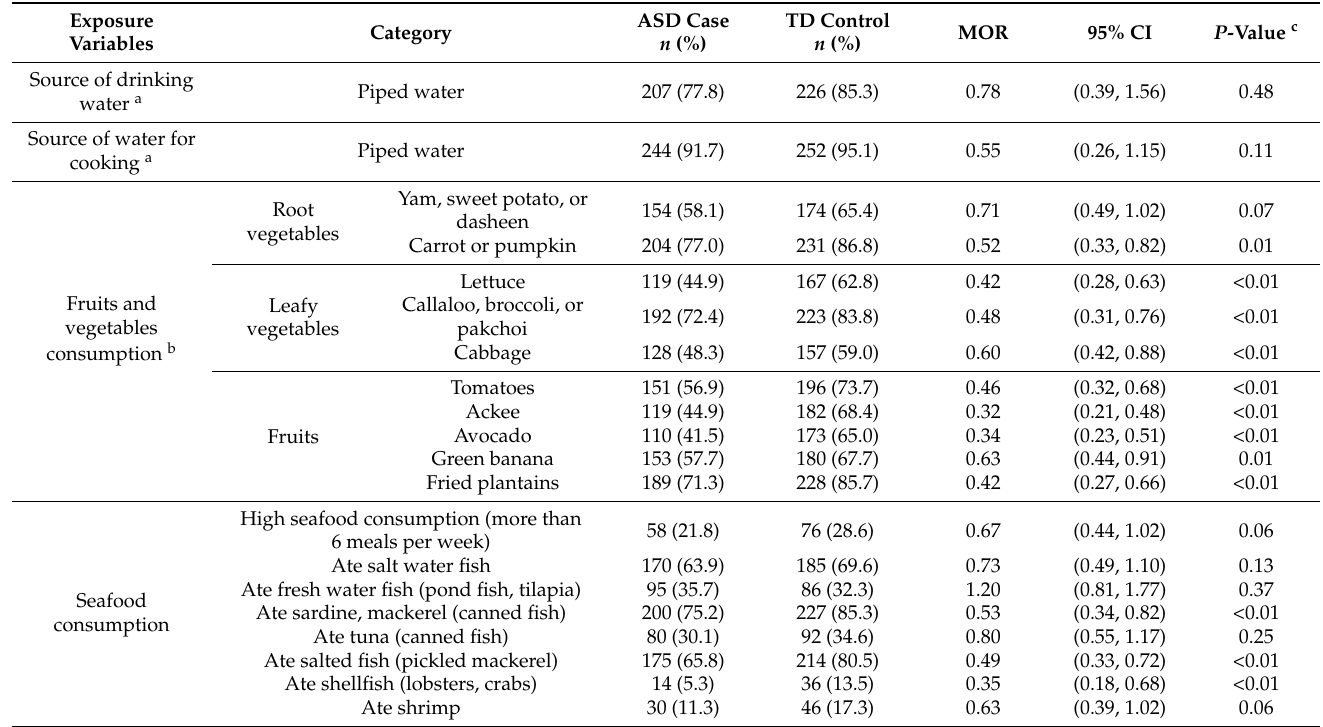
Table 2. Associations between dietary consumption and ASD case status using Conditional Logistic Regression (CLR) (266 matched